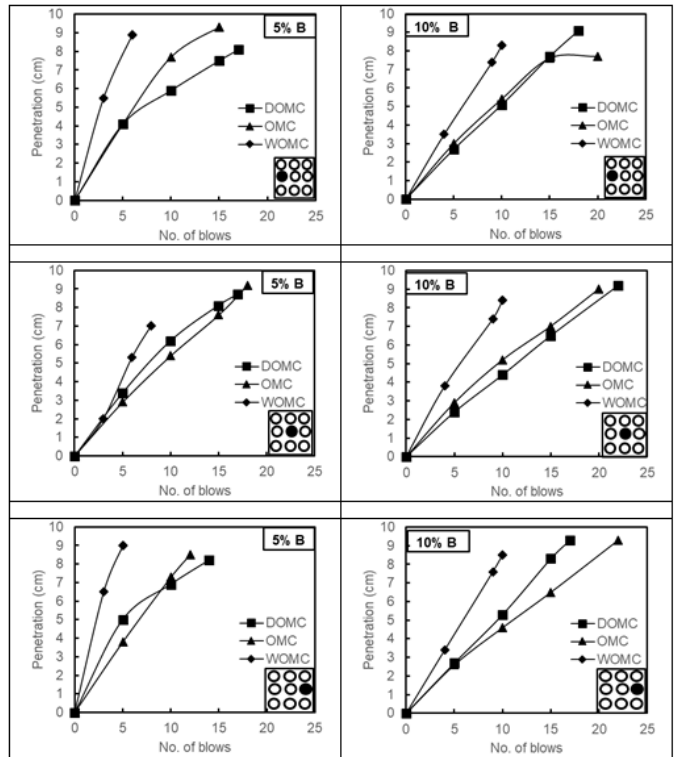
Figure 5. Penetration profiles for three points located along the central row (2) for 5% and 10% bentonite mixtures. Appl. Sci. 2022 , 12 , x FOR PEER REVIEW